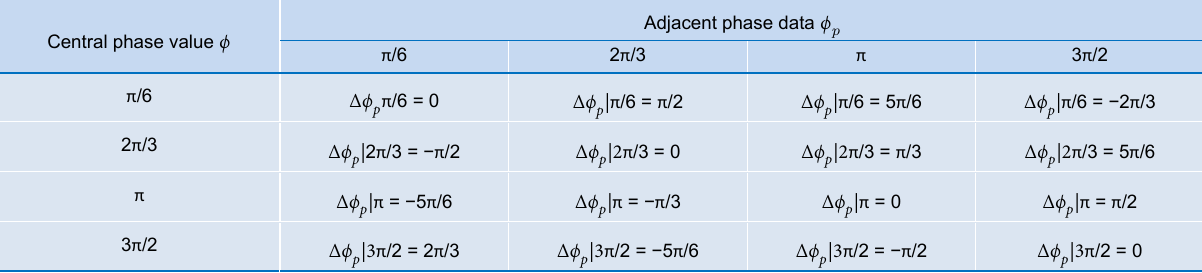
Table 3 | Possible phase difference ∆ ϕ p = ϕ p – ϕ under encoding rule (π/6, 2π/3, π, 3π/2). ϕ Central phase value